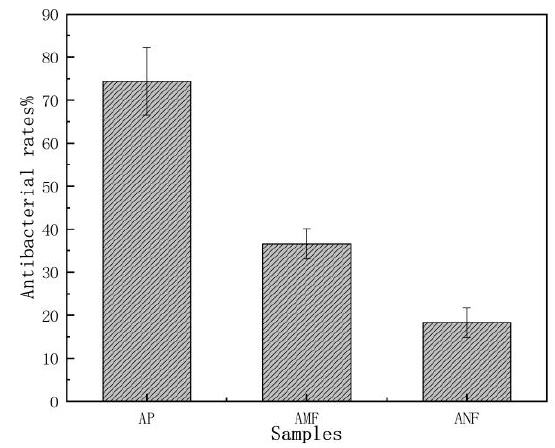
Figure 5. The antibacterial rates of Artemisia vulgaris bast powder, microcellulose fibers, and Artemisia vulgaris bast nanocellulose fibers.